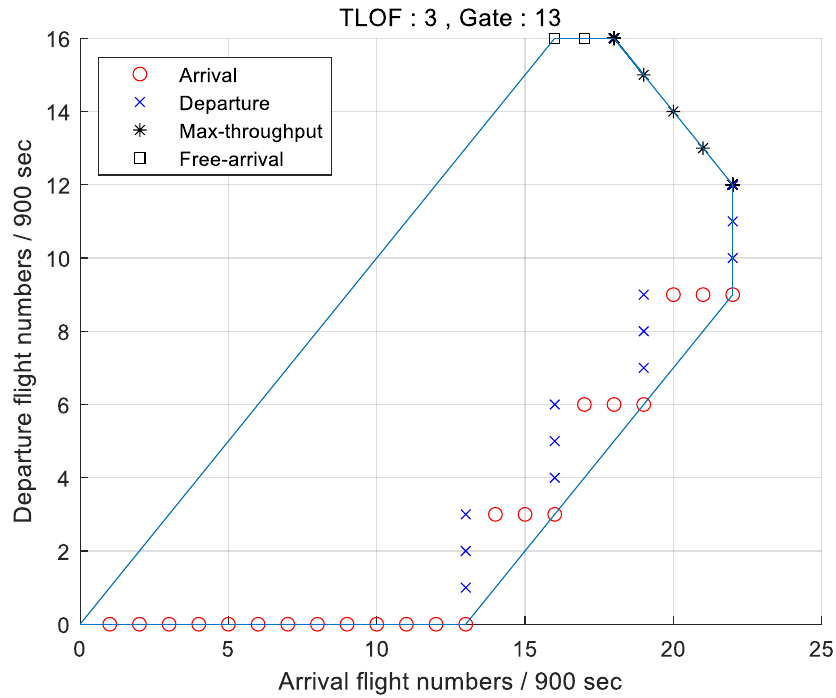
Figure 32. Capacity of a pier topology for the current Gimpo Airport parking lot that complies with the EASA’s new regulations.